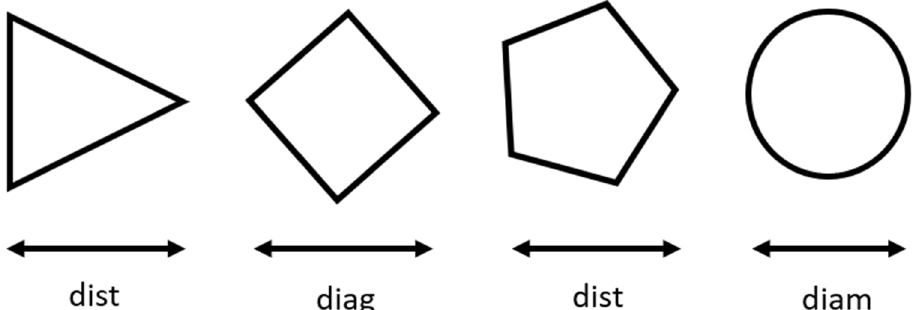
Figure 3. Different Geometry of PSA generation.